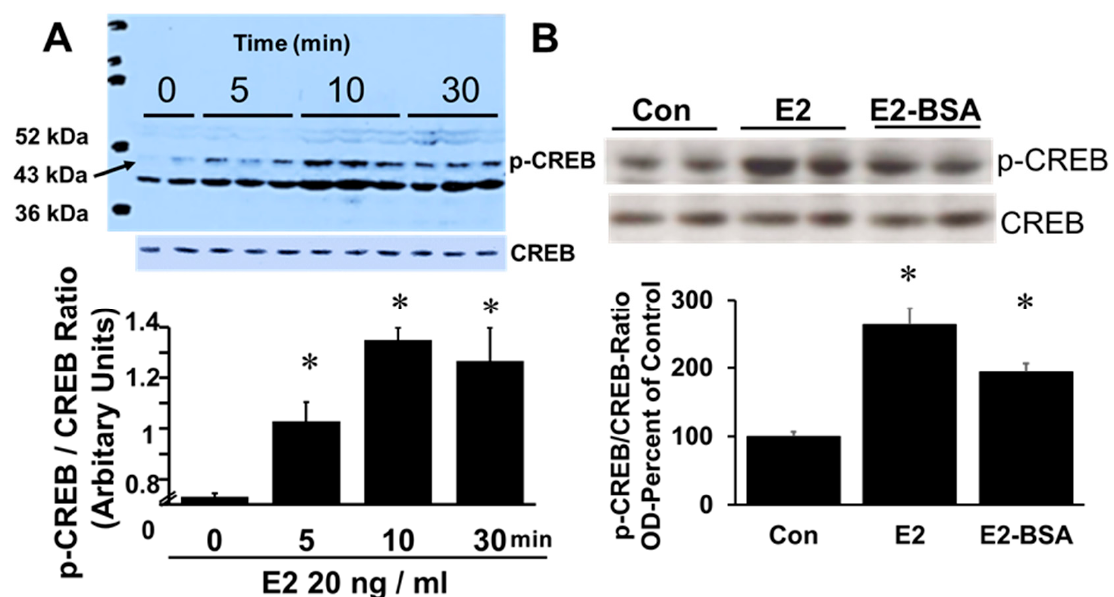
Figure 6. Panel ( A ) is a representative western blot showing the time-dependent (5, 10 and 30 min) phosphorylation of CREB (43 kDa protein) in response to 17 β -estradiol (E2; 20 ng/mL) and Panel ( B ) shows a blot with CREB phosphorylation after 30 min, in response to E2 (20 ng/mL) and BSA tagged E2 (E2-BSA; 20 ng/mL). Bar graph depicts densitometric analysis for changes in CREB phosphorylation and presented in arbitrary units following normalization with non-phosphorylated CREB. Data (mean ± SEM) are from 3 separate experiments each in duplicates. Results were normalized by the internal standard, CREB. * p < 0.05 vs. 0 min or untreated control.